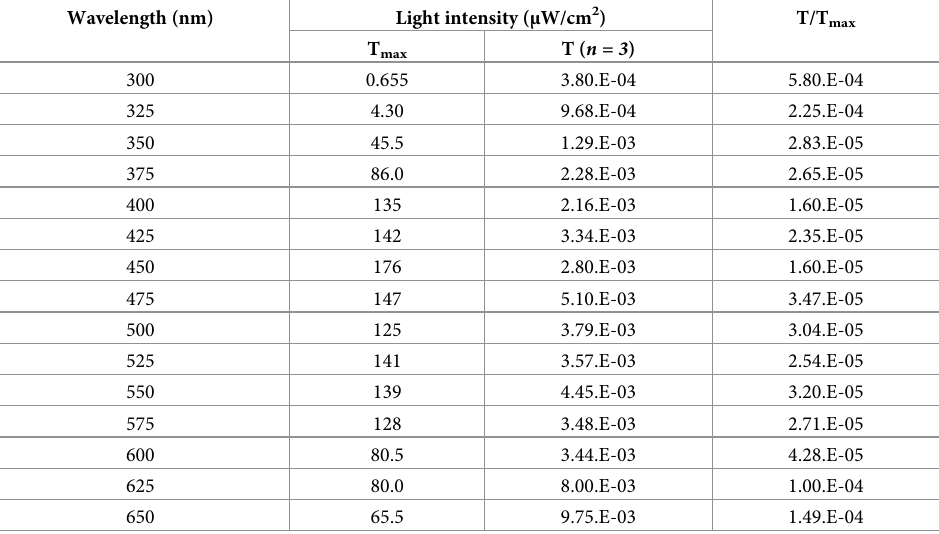
Table 1. Light intensity without a bird’s head (T max ) and at the hypothalamic level (T) at different